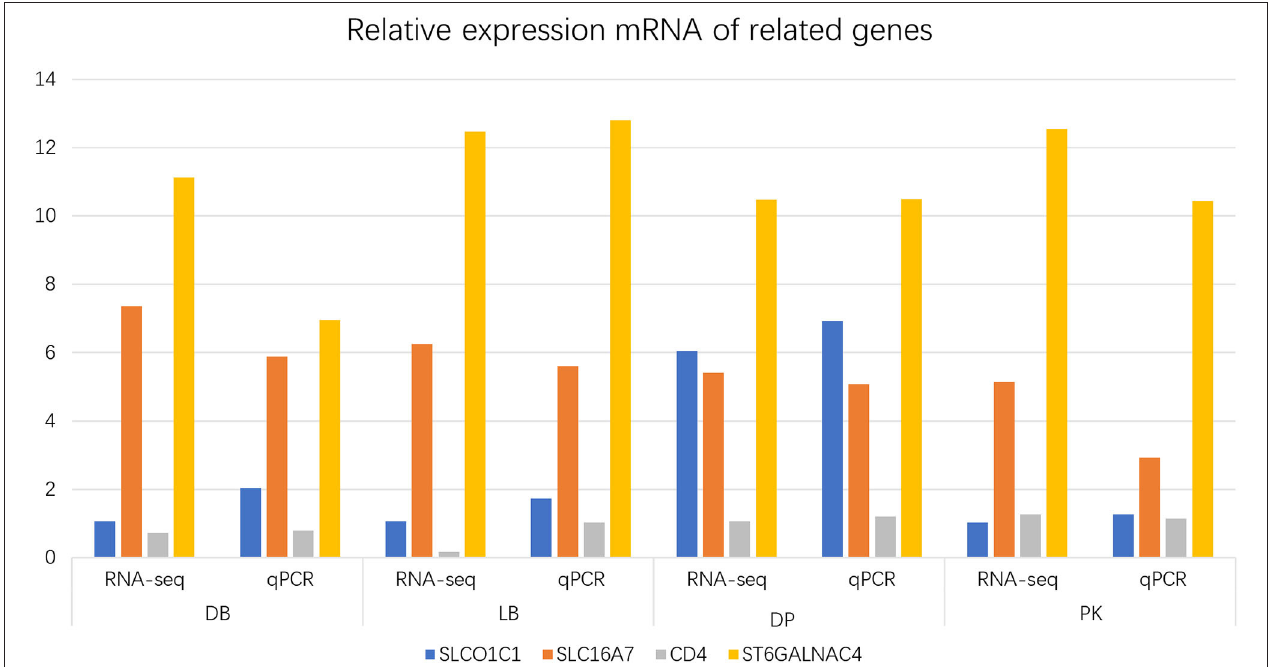
FIGURE 3 | Relative mRNA expression of related genes. DB, DP, LB, and PK mean chickens producing dark blue, dark brown and greenish, light blue, and pink eggshell eggs,